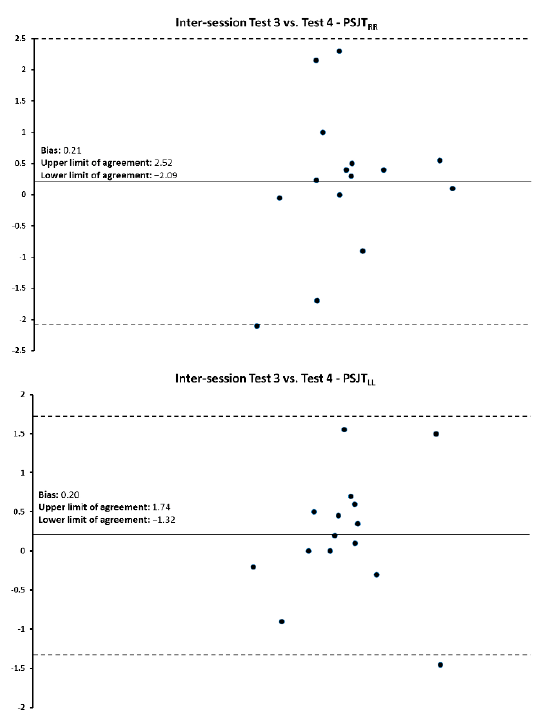
Figure 5. Bland–Altman plot for the intersession reliability between PSJT RLEG and PSJT LLEG for EGA. The difference between the two measurements per subject is plotted against the mean of the two measurements. The dotted lines represent the upper and lower limits of agreement for 95% CI.